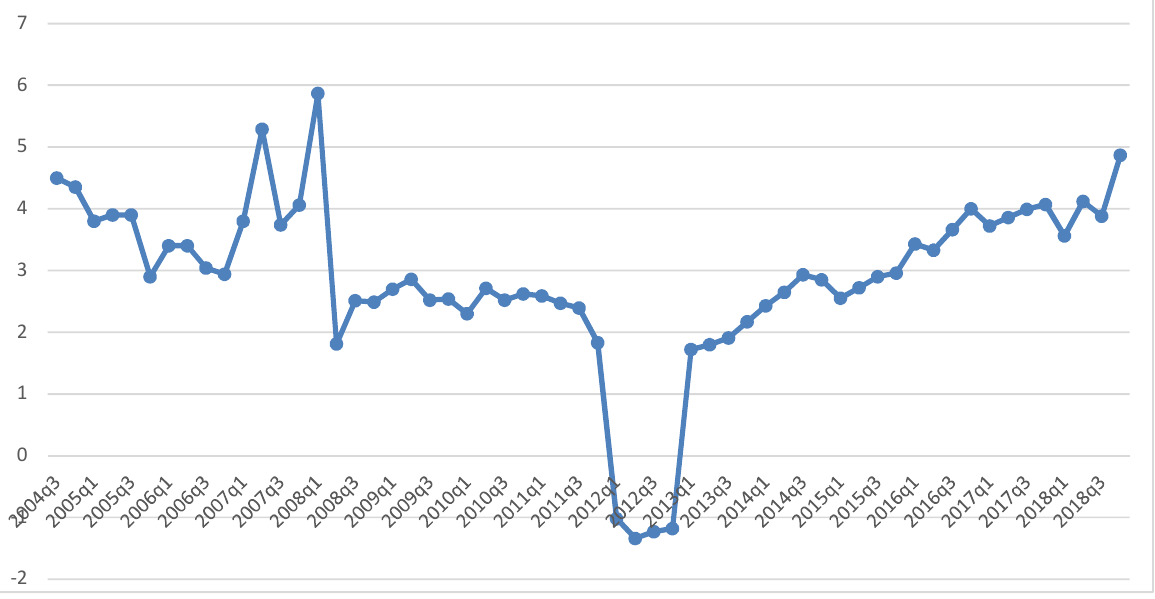
Fig. 1. Growth of the real estate market (REM) in Vietnam (2004:Q3-2018:Q4)